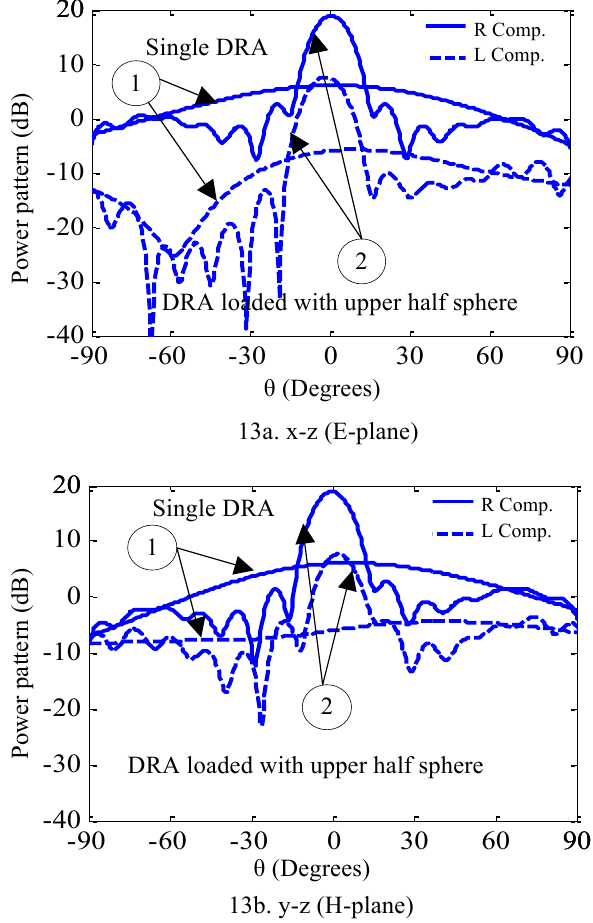
Figure 13: The E- and H- planes of circular polarization radiation patterns for the DRA loaded with upper half dielectric sphere compared to a single DRA at f = 10 GHz.